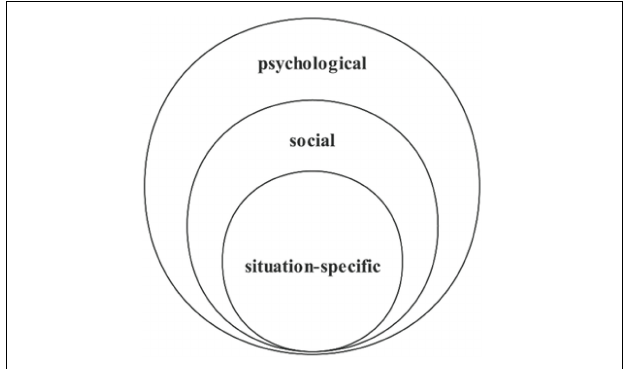
FIGURE 2 | The macro-, meso-, and microsystem of FL listening